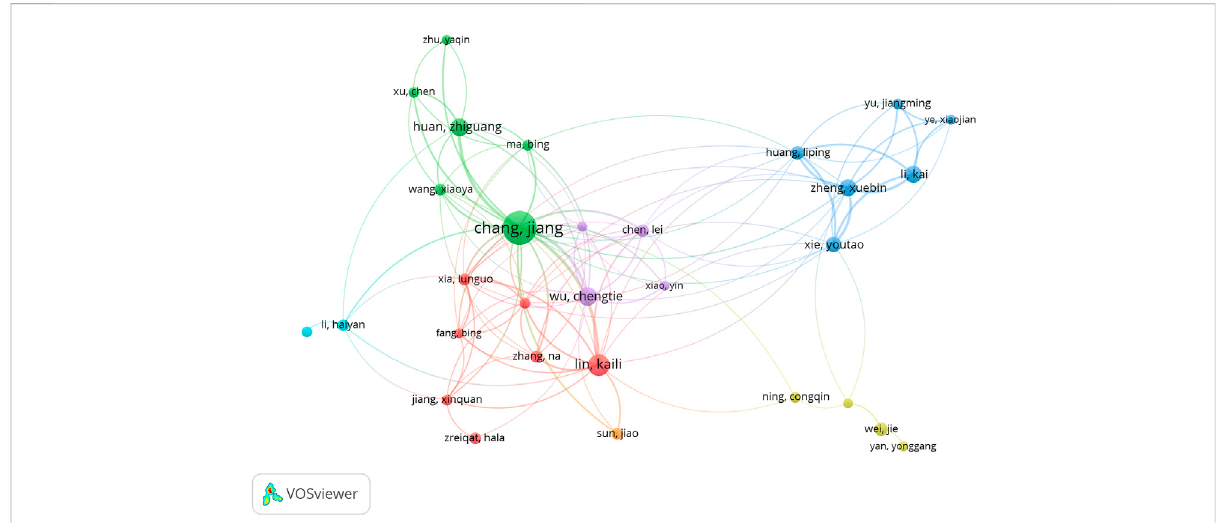
FIGURE 5 The co-authorship analysis. Network of authorship among authors in CSB in medical research and applications. The color indicated clusters, circle size indicated number of publications, the thickness of lines indicated strength of